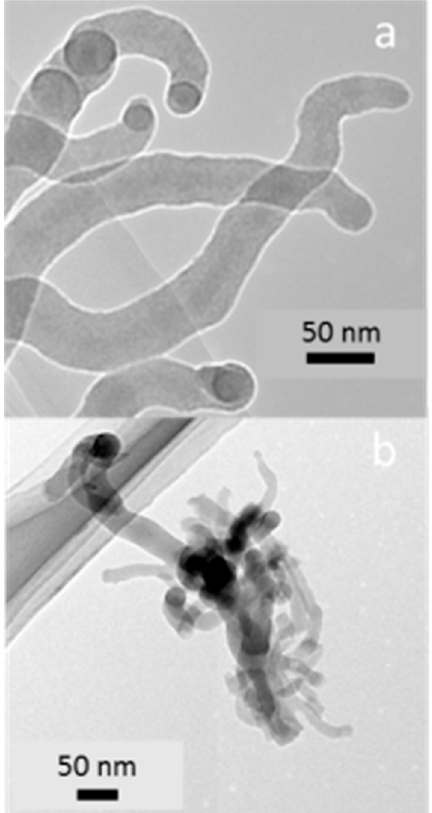
Figure 3. TEM images of carbon fingers. ( a ) TEM image of worm-like fingers; ( b ) TEM image of broken fingers in a cluster. C 2019 , 5 , x FOR PEER REVIEW